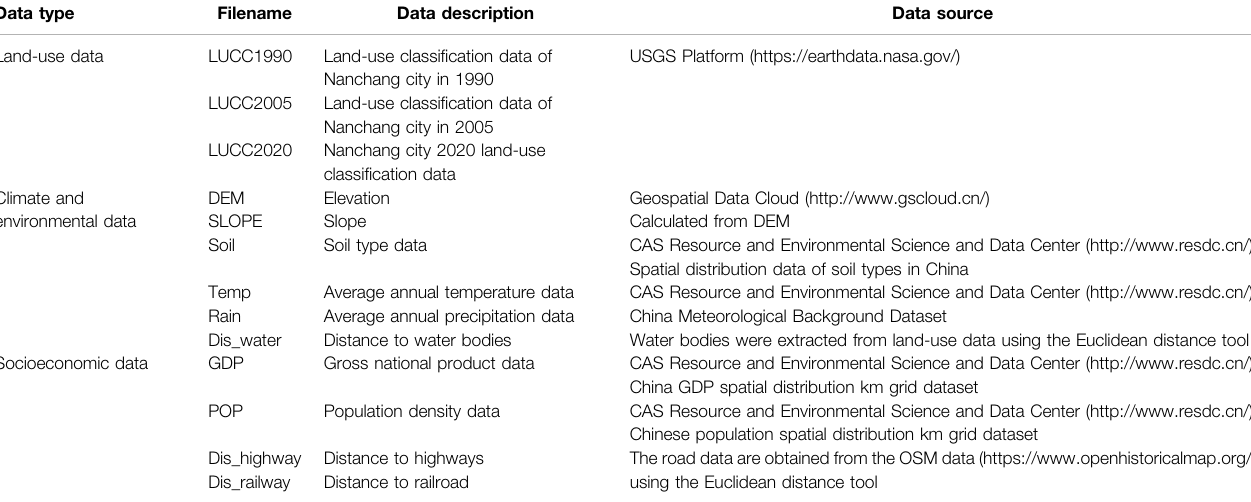
TABLE 1 | Data description and